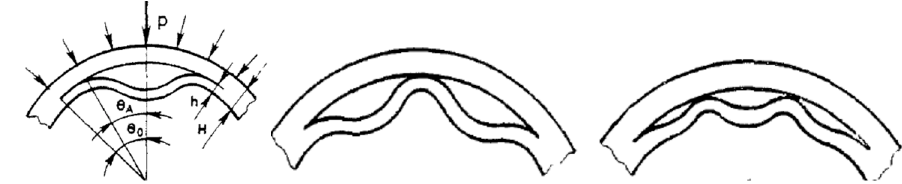
Figure 12. Forms of the loss of stability of delaminations in spherical shells.